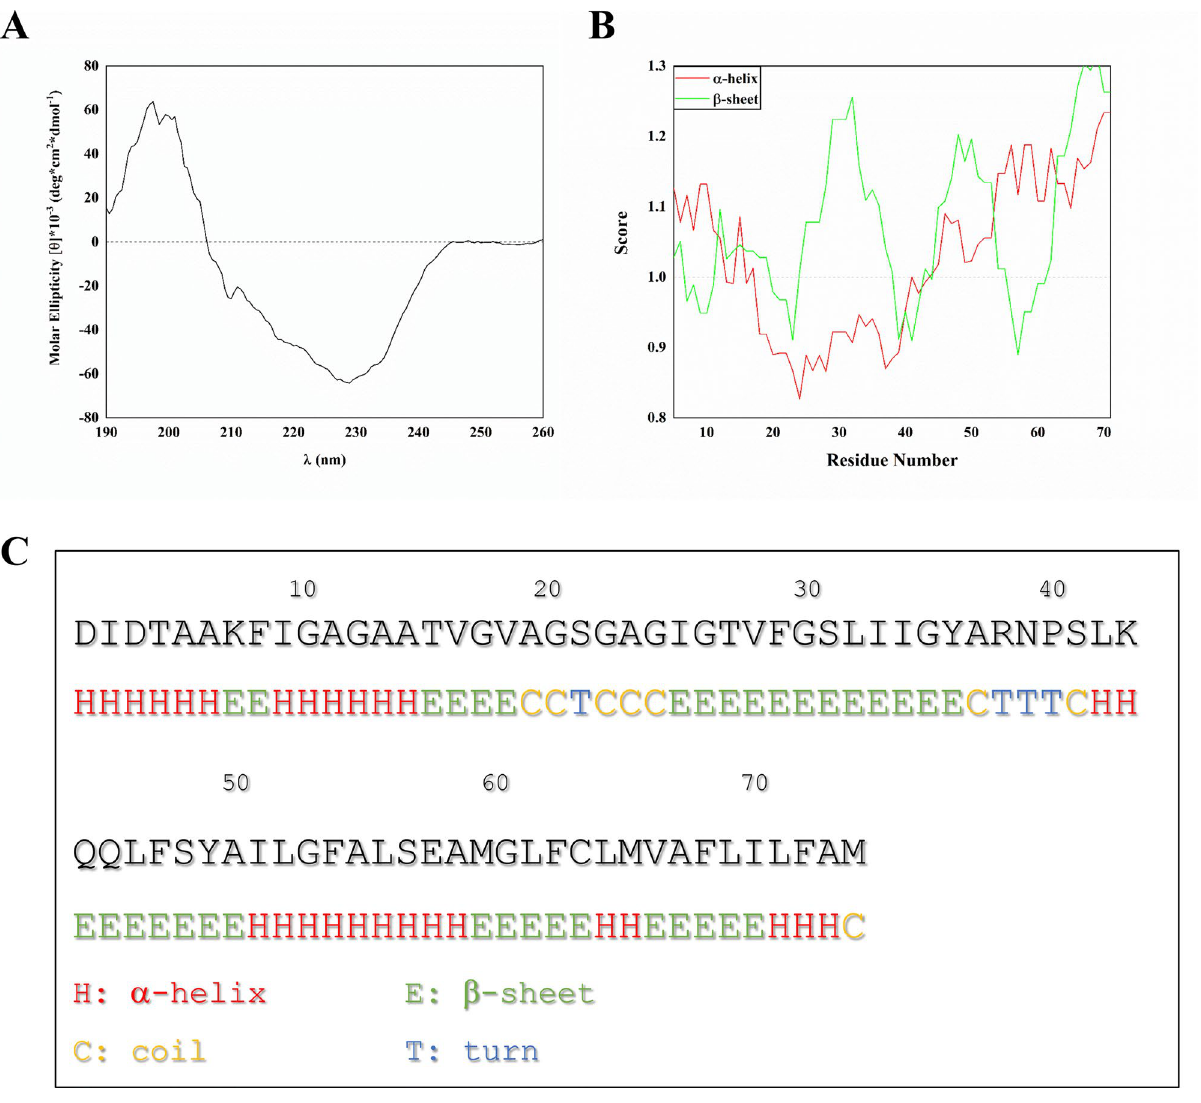
Figure 1. C subunit forms β-sheet structures. ( A ) CD spectrum of the 50 µM c subunit in 2% Genapol and PBS; ( B ) Bioinformatic prediction of the probability score of the secondary structure of the c subunit based